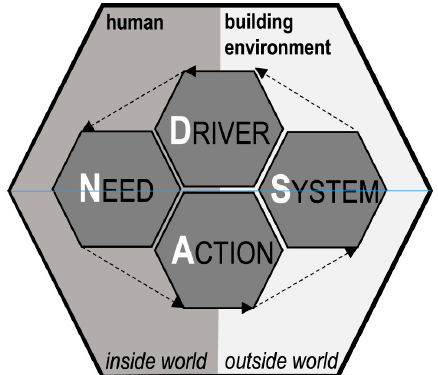
Figure 11. DNAs Framework Components [112] (Reprinted from Elsevier Building and Environment, Volume 92, Tianzhen Hong, Simona D’Oca, William J.N. Turner, Sarah C. Taylor ‐ Lange, An ontology to represent energy ‐ related occupant behavior in buildings. Part I: Introduction to the DNAs framework, Pages No. 764–777, Copyright (2015), with permission from Elsevier [OR AP ‐ PLICABLESOCIETY COPYRIGHT OWNER]).